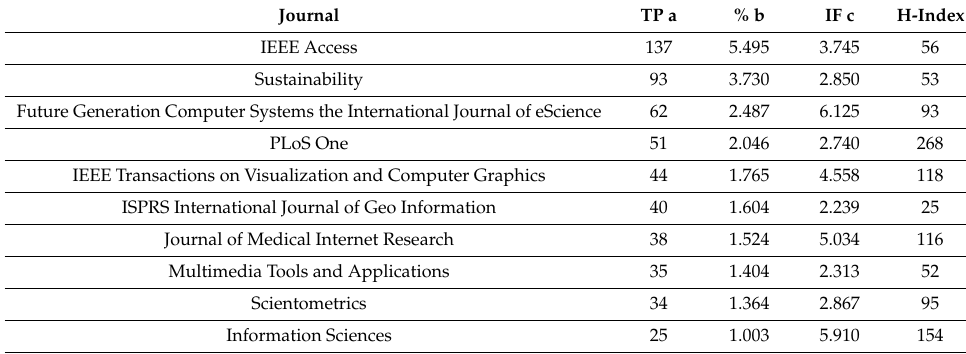
Table 2. Top 10 journals by number of publications.